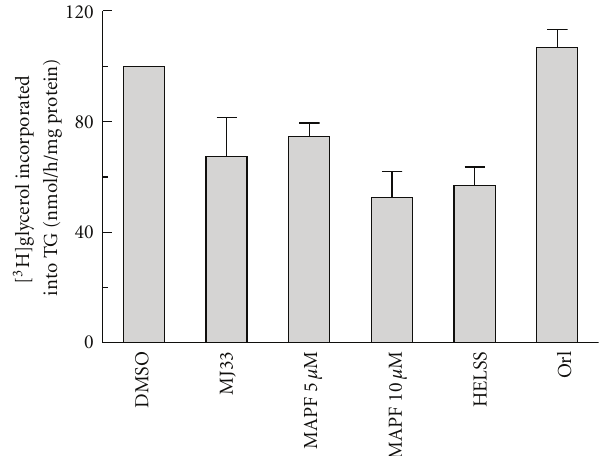
Figure 6: Role of macrophage lipase activities in TG synthesis. HMDM were preincubated for 2 h with or without 10 μ M MJ33, 5 μ M and 10 μ M MAFP [36], 5 μ M HELSS, and 2 μ M orlistat. Incubation was then continued for 5h in presence of CRLPw/o (80 μ g cholesterol/mL) in the presence of [ 3 H]glycerol (4 μ